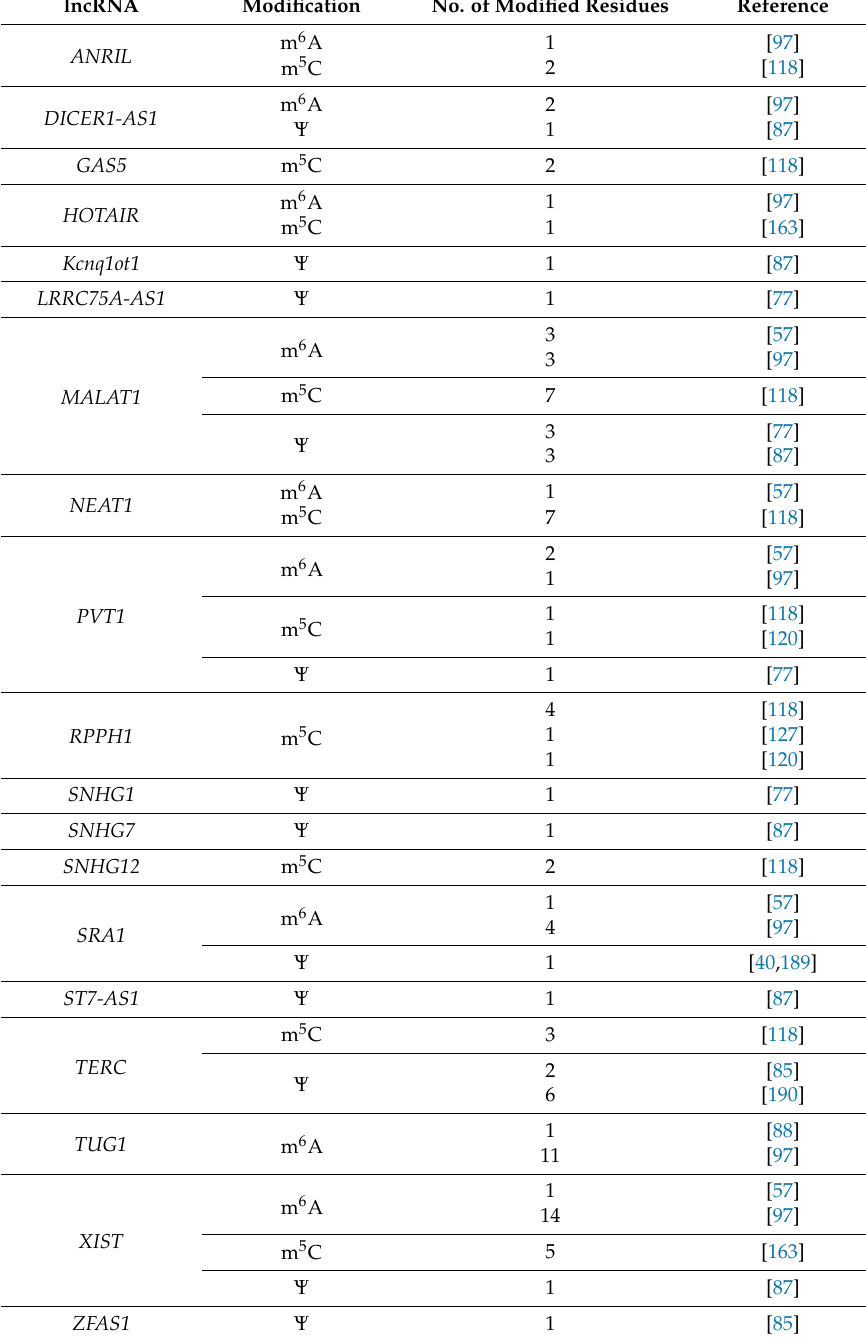
Table 2. Selected lncRNAs and their recently identified chemical